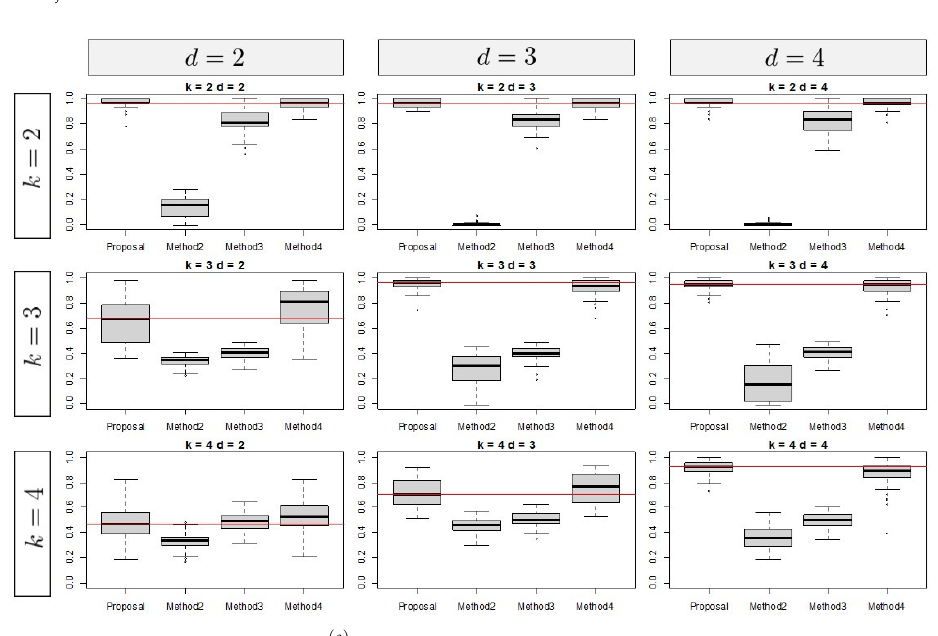
( s ) = 0.2 ( s = 1,2,3; i (cid:54) = j ) . Figure 4. Simulation result for σ ij From the overall results, we note two specific observations. First, the number of clusters is relatively large and performance tends to be relatively low, irrespective of the type of method; this tendency has been reported in [35]. Second, all methods depend on the selection of hyperparameters. Based on the simulation results, the tuning parameters should be set to d ≤ k